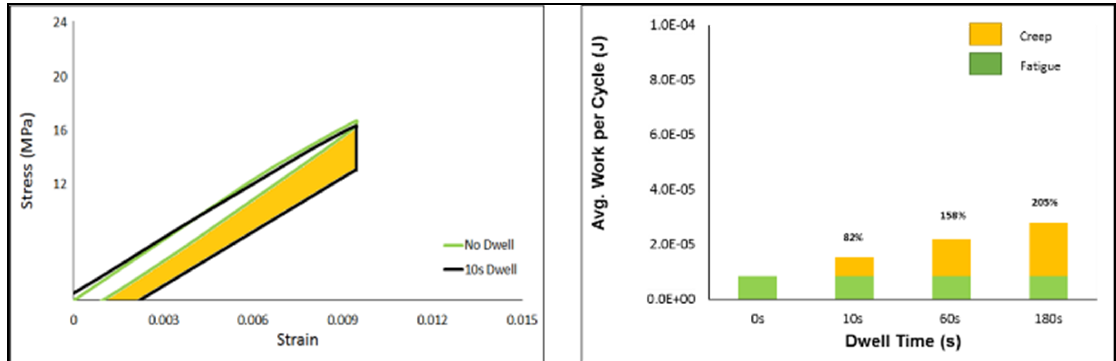
Figure 22. Hysteresis loops ( right ) with no dwelling and with 10 s dwelling cycled at 16 MPa, and a bar chart ( left ) for average inelastic work for both cases.